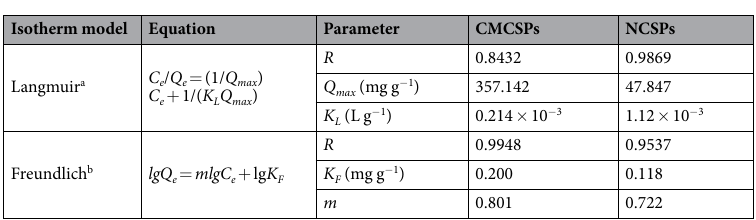
Table 2. Static Adsorption Fitting Data of the CMCSPs and NCSPs. a Q e (mg g − 1 ) is the binding capacity; C e (mg L − 1 ) is equilibrium concentration in the solution; Q max (mg g − 1 ) is the theoretical maximum adsorption amount; K L (L mg − 1 ) is the adsorption equilibrium constant. b K F is a Freundlich constant related to the adsorption capacity; m is a constant representing the adsorption intensity or surface